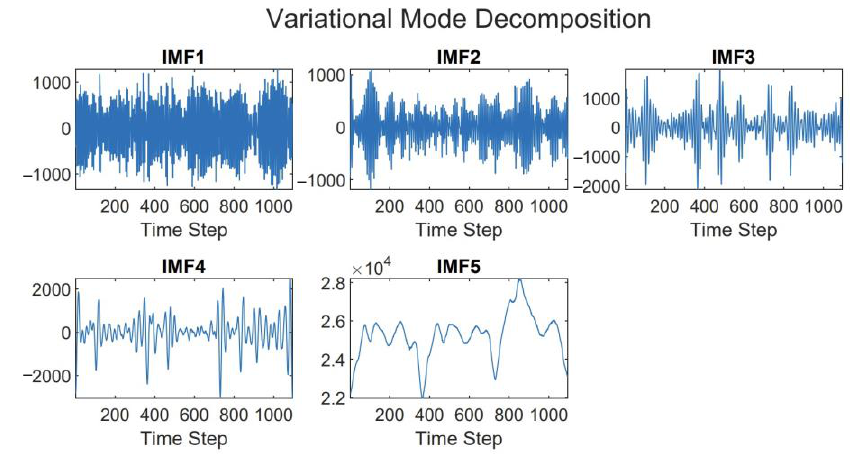
Figure 7. Daily electricity peak load between 2016 and 2018.